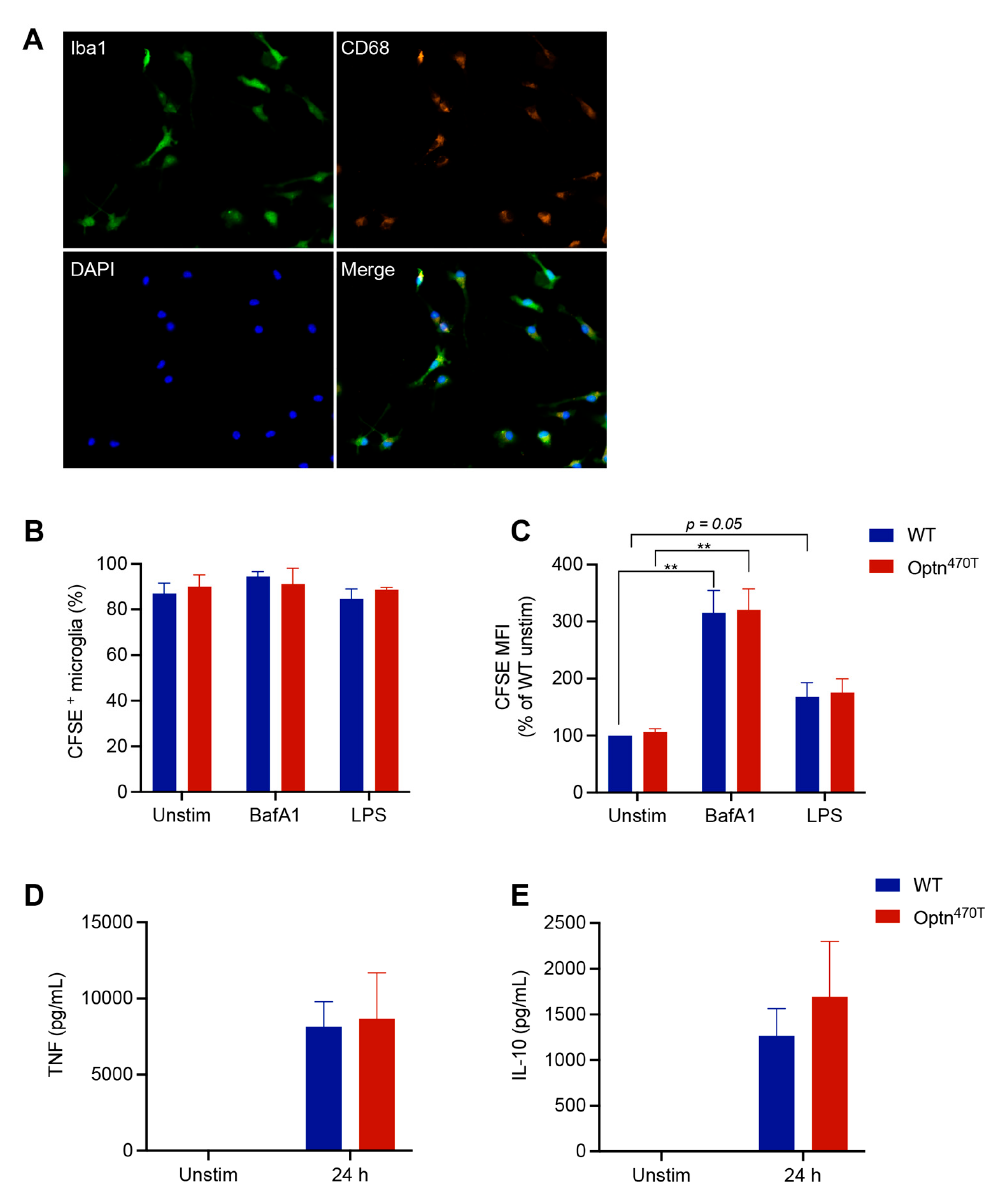
Figure 5. Optineurin function was dispensable for phagocytosis in primary microglia. Primary neonatal microglia were generated by co-culture with astrocytes. ( A ) Successful isolation and purity of WT microglia upon detachment from the astrocyte layer was assessed by immunofluorescence staining for Iba1 (green), CD68 (orange), and DAPI (blue). Representative single colour and merged images are shown. Microglia was labelled with CellTrace Far Red dye and incubated with CFSE- labelled N2A debris for 5 h. When indicated, BMDMs were pretreated with 500 ng/mL of LPS for 24 h or treated with 200 nM BafA1 for 4 h before collection (remark: due to paucity of primary microglia generated per pup, we limited our experiments to these selected conditions). Phagocytosis was assayed by flow cytometry and ( B ) percentage of phagocytic cells, and ( C ) CFSE MFI (normalized to WT unstimulated cells) was determined. Supernatants from unstimulated and LPS-pretreated microglia were assayed by ELISA for ( D ) TNF- α and ( E ) IL-10. The data are shown as mean ± SEM of two to four independent experiments. Statistical analysis was done by unpaired Student’s t -test; ** p < 0.01.